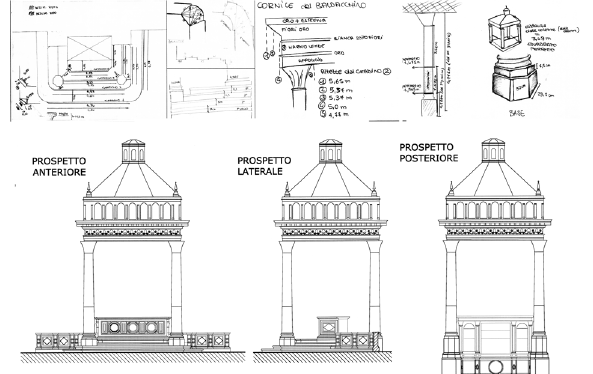
Figure 12. Eidotipo (the Basilica of San Pietro in Vincoli in Rome).